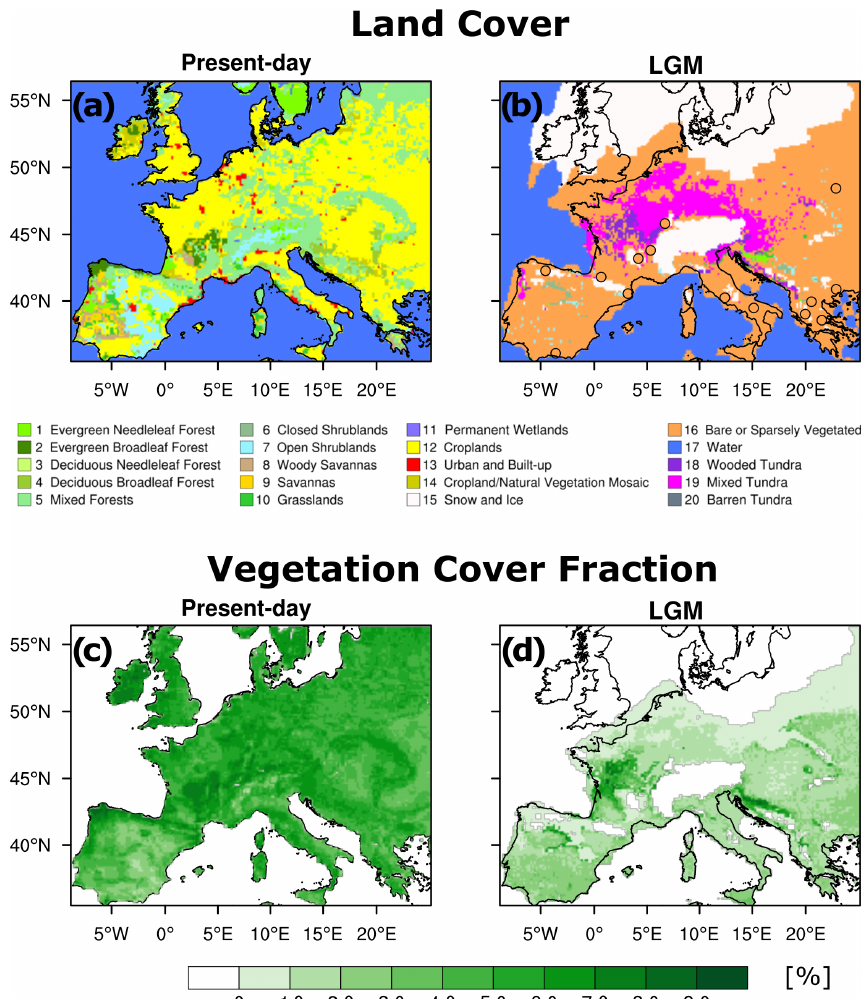
Figure 2. Land cover used by WRF. Panel (a) represents the dominant land cover category during PD. Panel (b) is the same as (a) but during the LGM. Panels (c) and (d) are the same as (a) and (b) but for vegetation cover fraction. Circles in (b) represent proxy evidence from Wu et al.